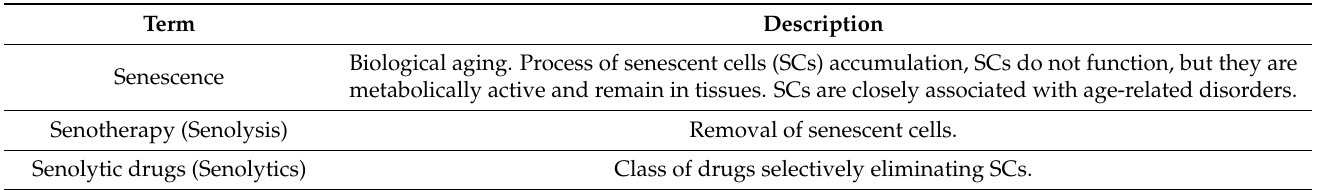
Table 2. Basic glossary of new terms associated with senescence and